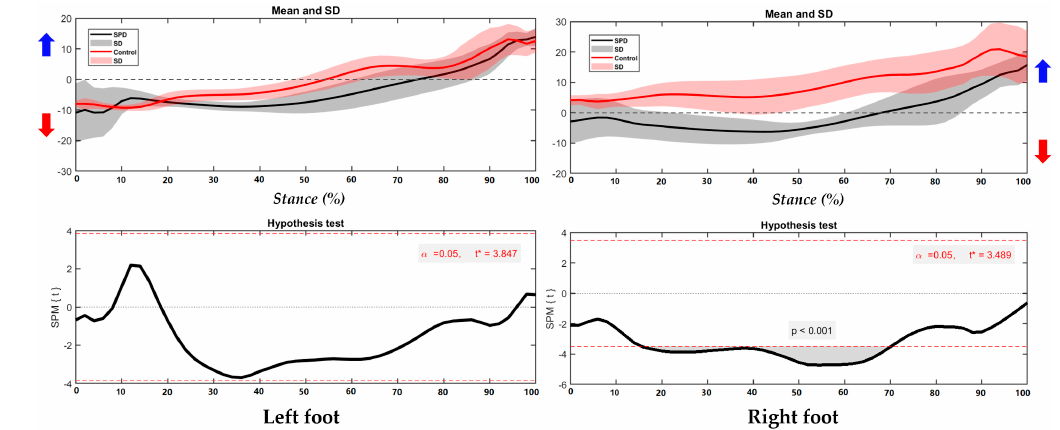
Figure 3. The COP of trajectory in the left foot and right foot during running with highlighted direction of pronation (Blue arrow) and supination (Red arrow).